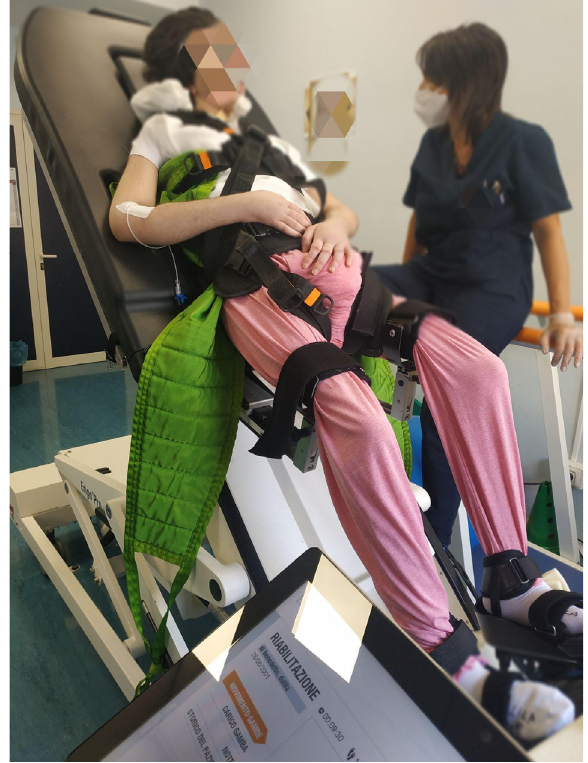
Figure 1. A patient with MCS during a music robotic verticalization session.